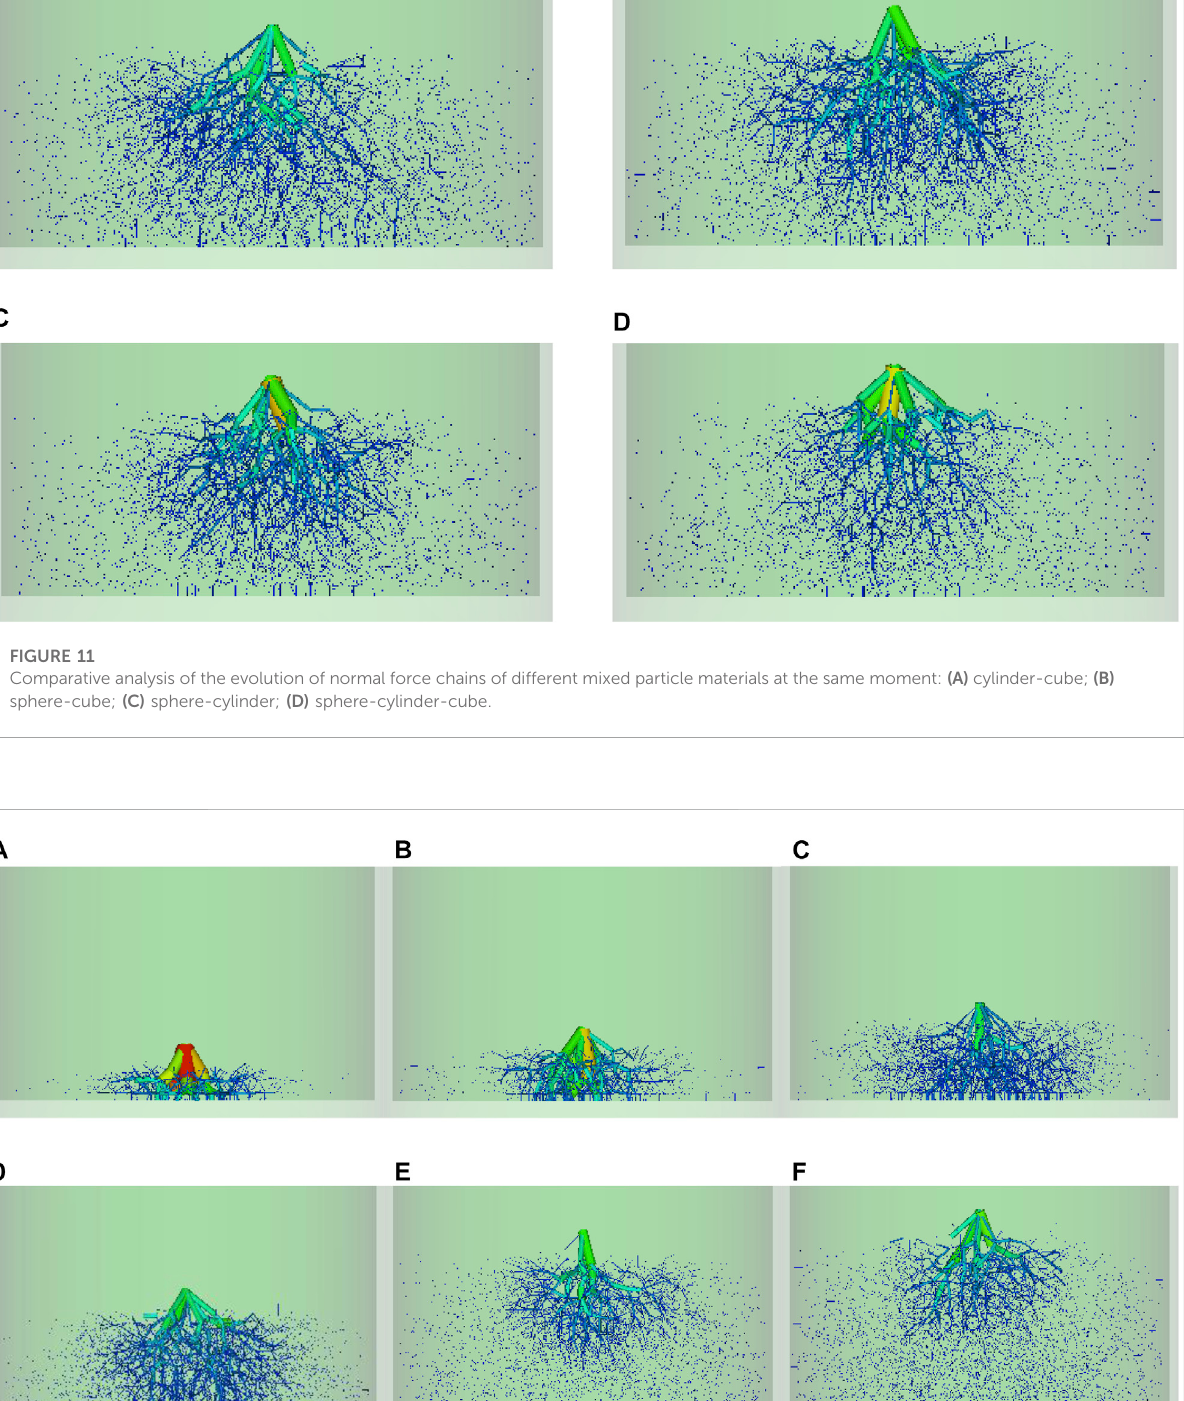
Frontiers in Earth